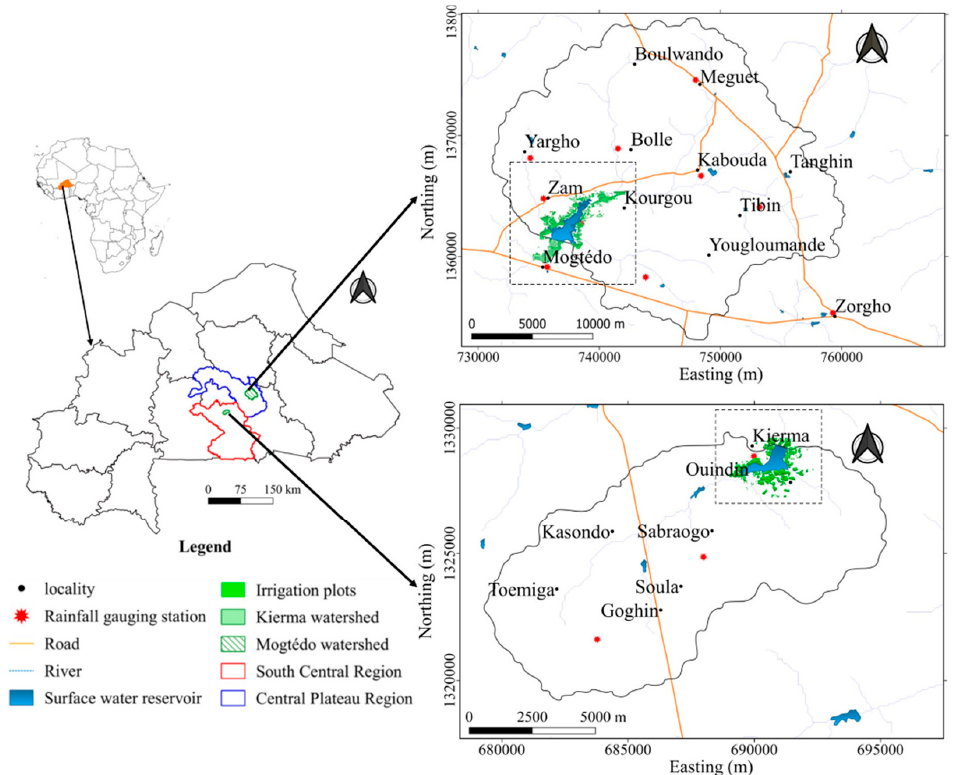
Figure 1. Details of the location of surface water reservoirs (SWRs) in the study areas. The dashed rectangles indicate the investigated sites around the Mogtédo and Kierma dams.